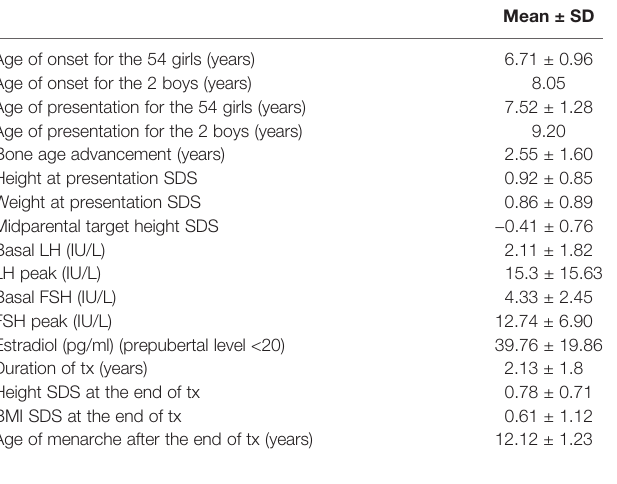
TABLE 1 | Clinical and hormonal features of 56 patients ( n = 54 girls; n = 2 boys) with CPP.